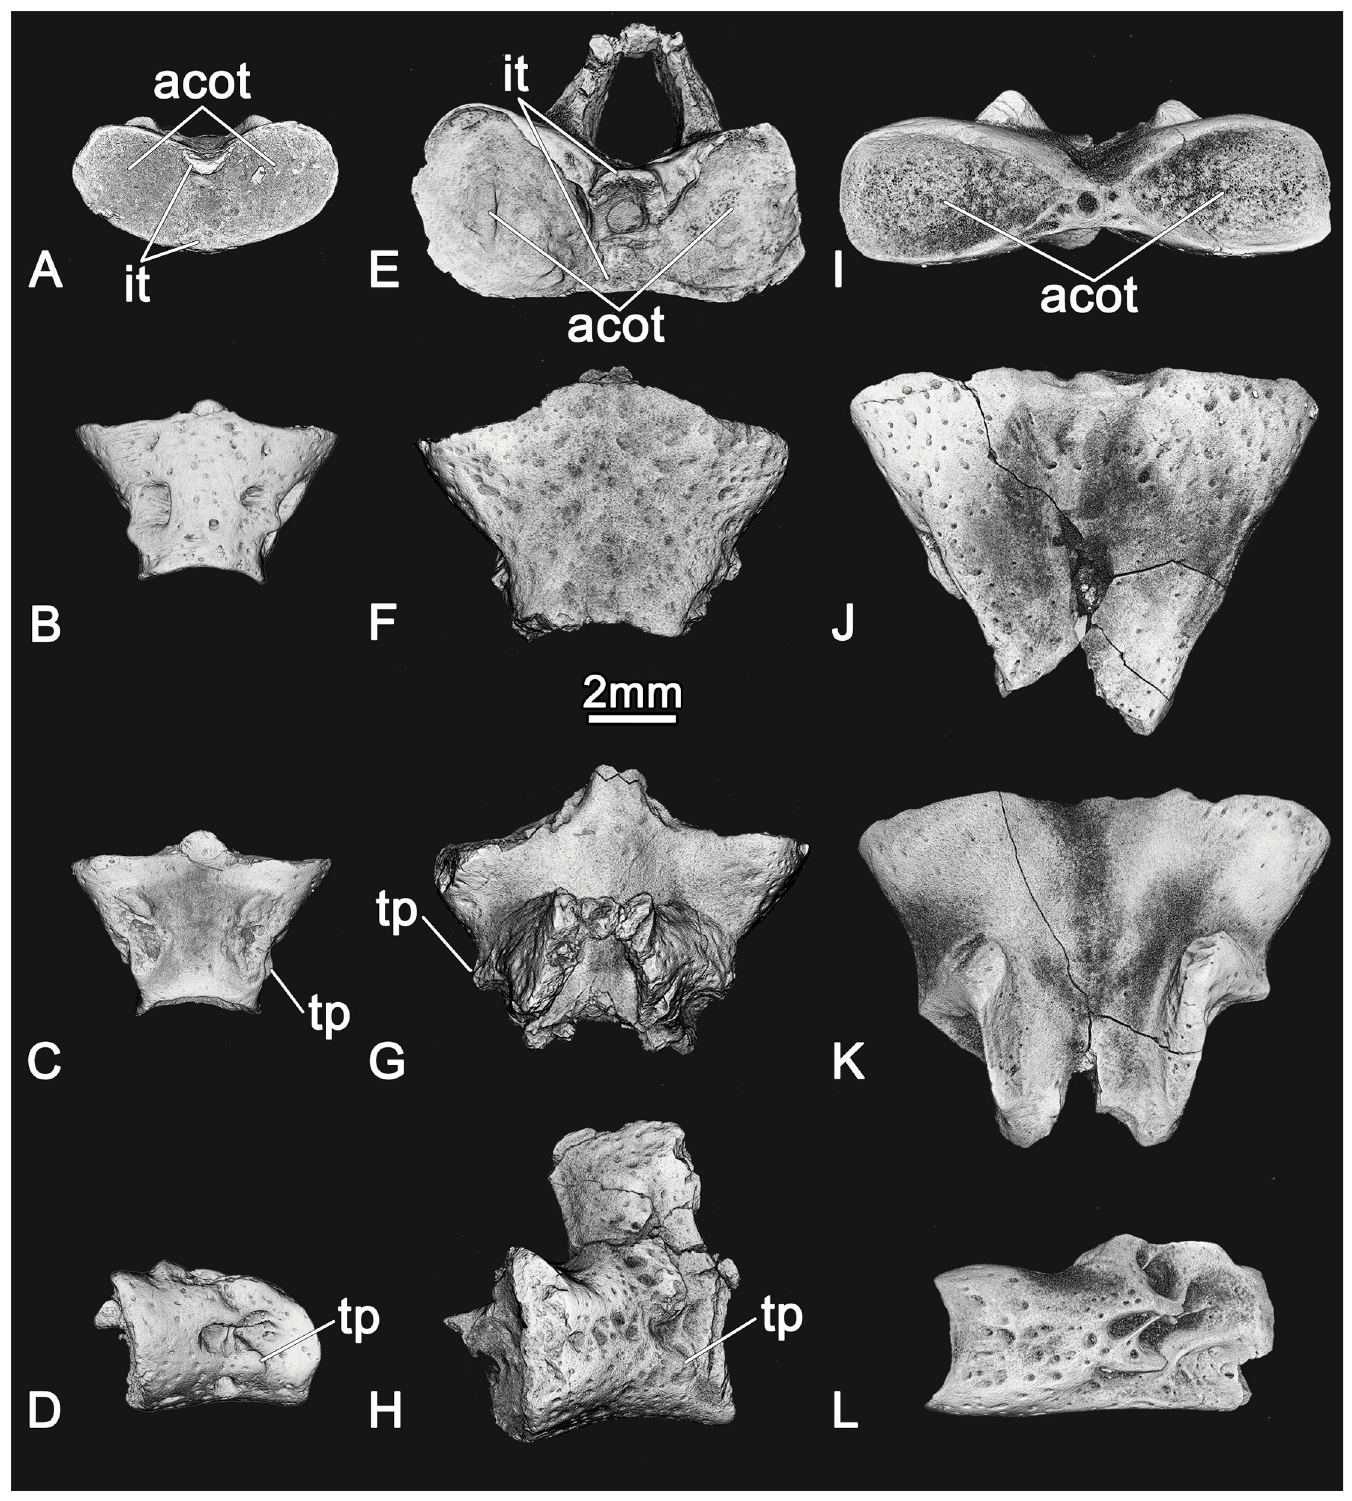
Fig 6. Digital reconstructions of atlases of representative stem group salamanders: A–D, Egoria malashichevi gen. et sp. nov., ZIN PH 40/144 (holotype) in anterior (A), ventral (B), dorsal (C) and left lateral (D) views; E–H, Kokartus honorarius , ZIN PH 3/47 (referred specimen) in anterior (E), ventral (F), dorsal (G) and left lateral (H) views; I–L, Urupia monstrosa ZIN PH 1/144 (holotype) in anterior (I), ventral (J), dorsal (K) and left lateral (L) views. Abbreviations: acot–anterior cotyle, it–intercotylar tubercle, tp–transverse process. All images at same magnification.